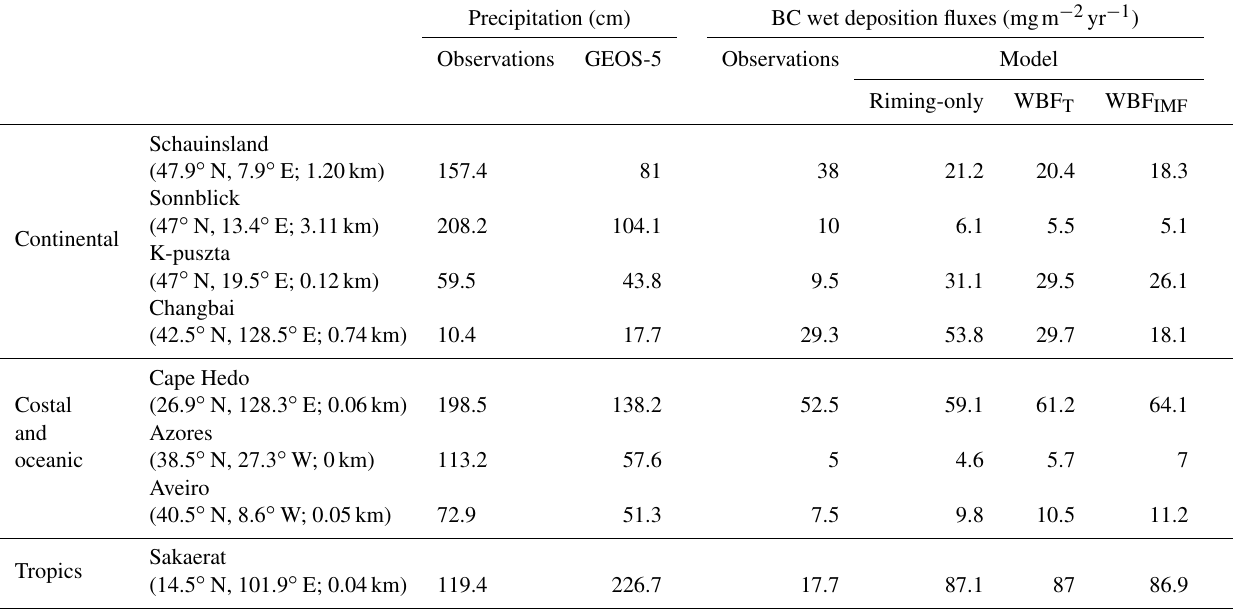
Table 3. Observed and simulated precipitation (cm) and BC wet deposition fluxes (mgm − 2 yr − 1